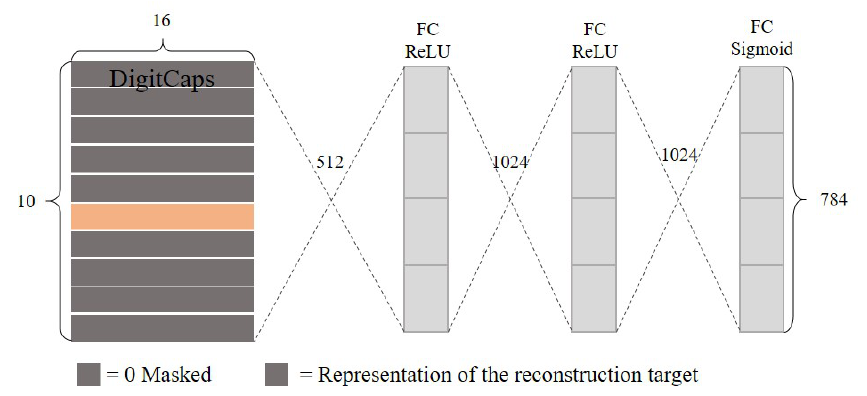
Figure 2. Decoder structure to reconstruct the